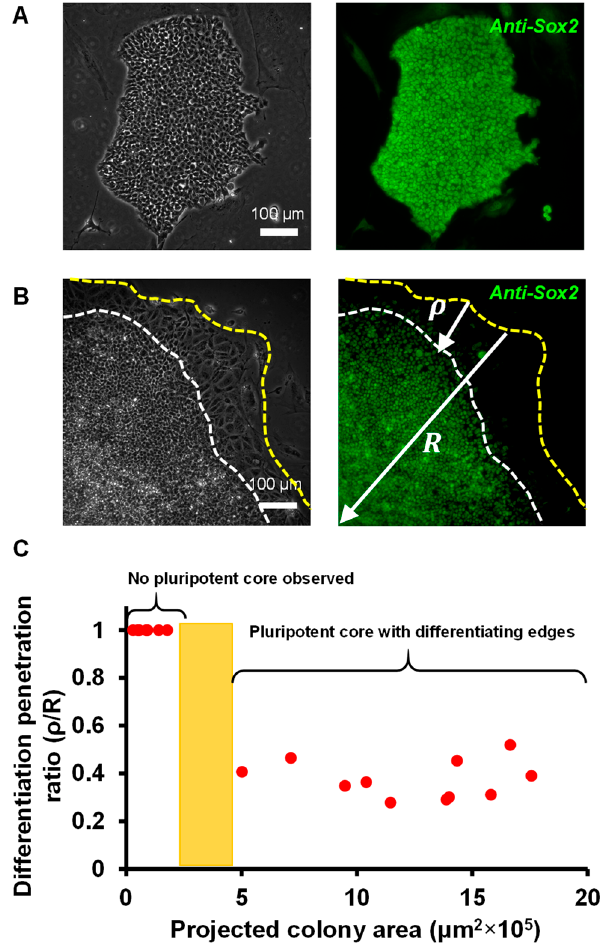
Figure 2. Pluripotency marker Sox2 is differentially expressed in differentiating EpiSC colonies. ( A ) Immunofluorescent labeling of pluripotency marker Sox2 in EpiSCs cultured on mitotically inactivated feeders showing no differentiating periphery. ( B ) A phase image (left) and the corresponding fluorescent image (right) show Sox2 expression in a differentiating colony. Sox2 was primarily expressed in the colony center. The outer peripheral band of the EpiSC colonies was found to be Sox2 negative. To model the differentiation effect, an average radial distance of differentiation, ρ , was defined. The radius of the colonies, R , was approximated by fitting a circle of known radius. ( C ) The scatter plot shows the ratio ρ as a function of the total area of the colonies. A ρ value of smaller than 1.0 indicates differentiation heterogeneity, which was found to be pronounced when the projected colony area was > 5 × 10 5 µm 2 .